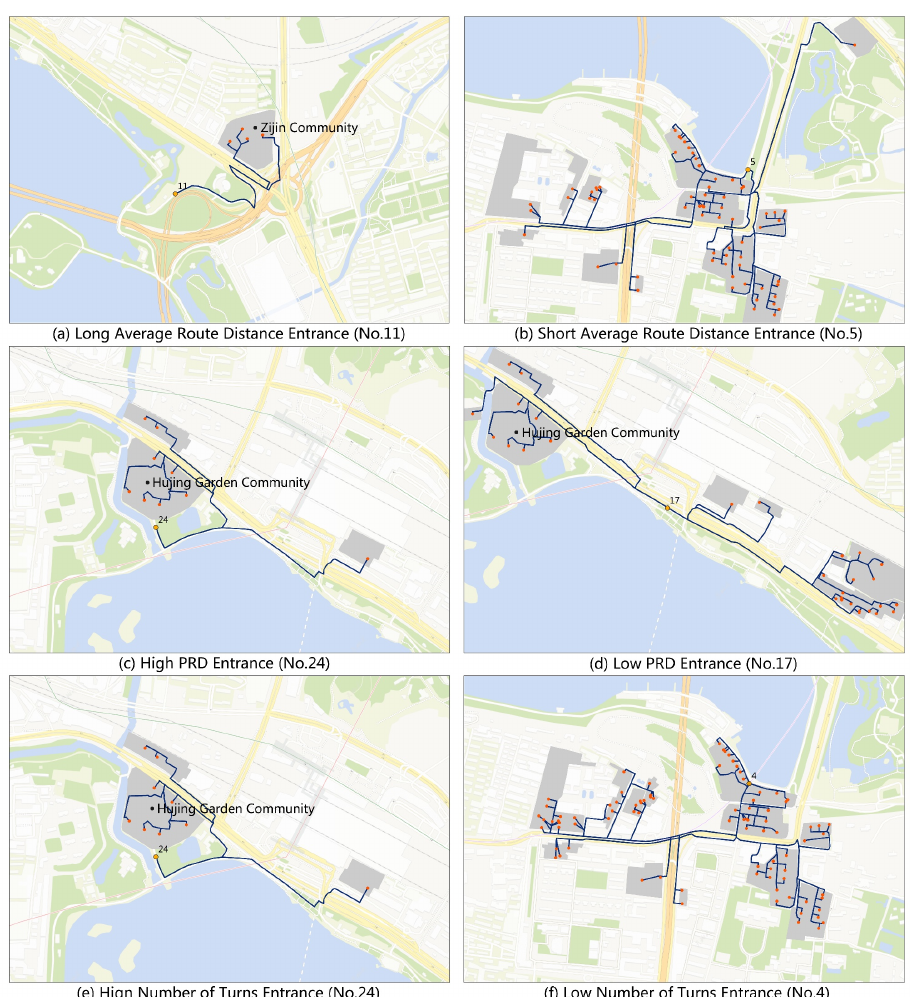
Figure 5. Cases of indices of entrances: ( a ) long average route distance entrance; ( b ) short average route distance entrance; ( c ) high PRD entrance; ( d ) low PRD entrance; ( e ) high number of turns entrance; and ( f ) low number of turns entrance (Base map from Tianditu Map).